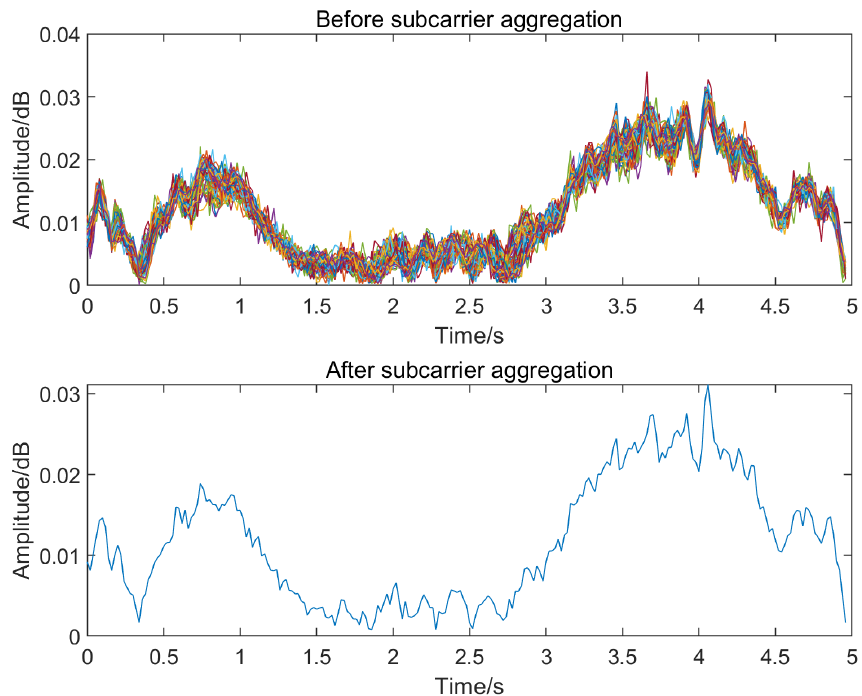
Figure 3. Amplitude comparison before and after subcarrier aggregation.